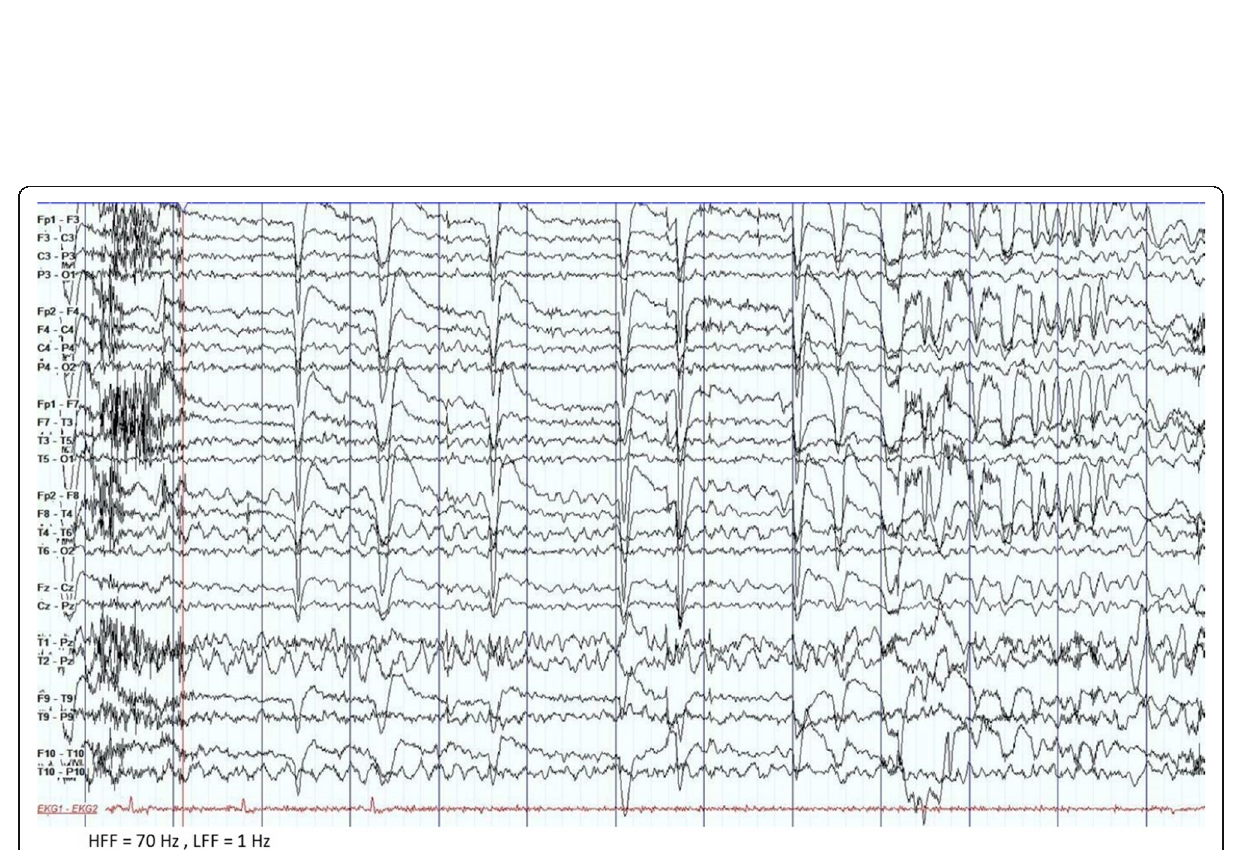
Fig. 1 Epoch A of the EEG recording demonstrates seizure onset. The electrographic seizure starts with a semi-rhythmic 4.5-Hz activity over the right temporal region. Starting from 9th second, heart rate begins to drop as demonstrated on the ECG strip